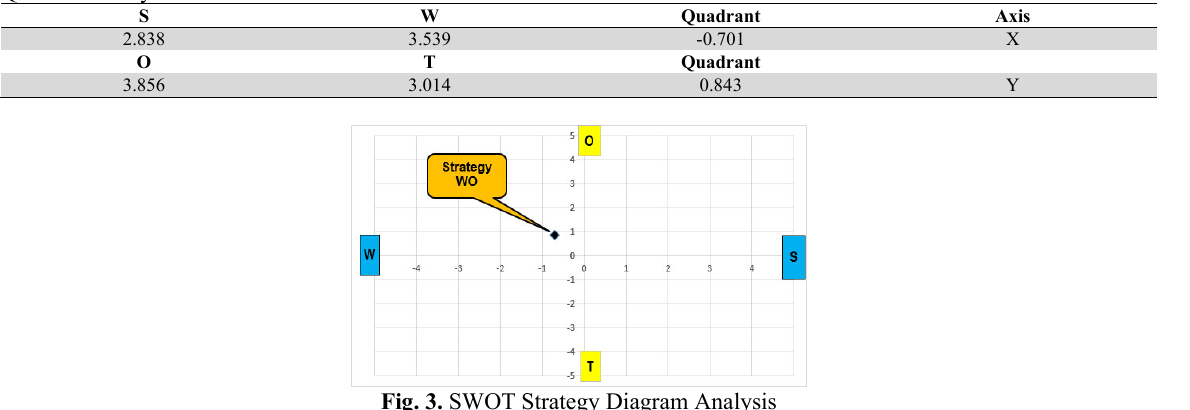
Fig. 3. SWOT Strategy Diagram Analysis